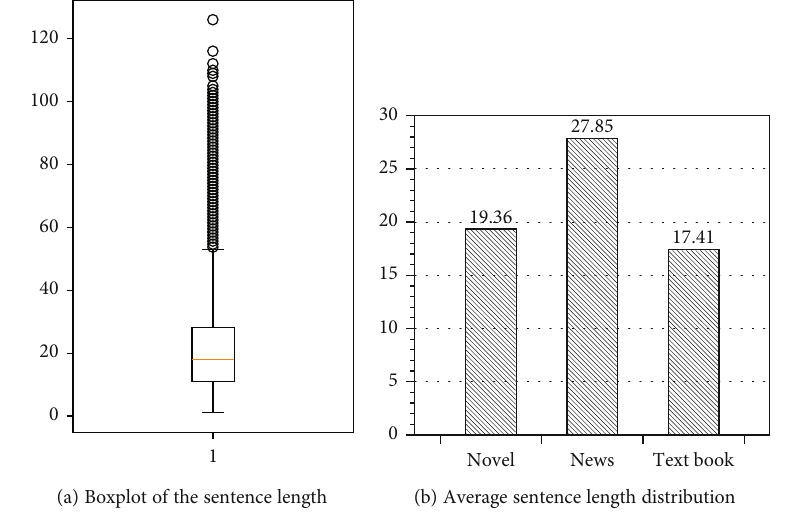
Figure 3: Sentence length boxplot and average sentence length